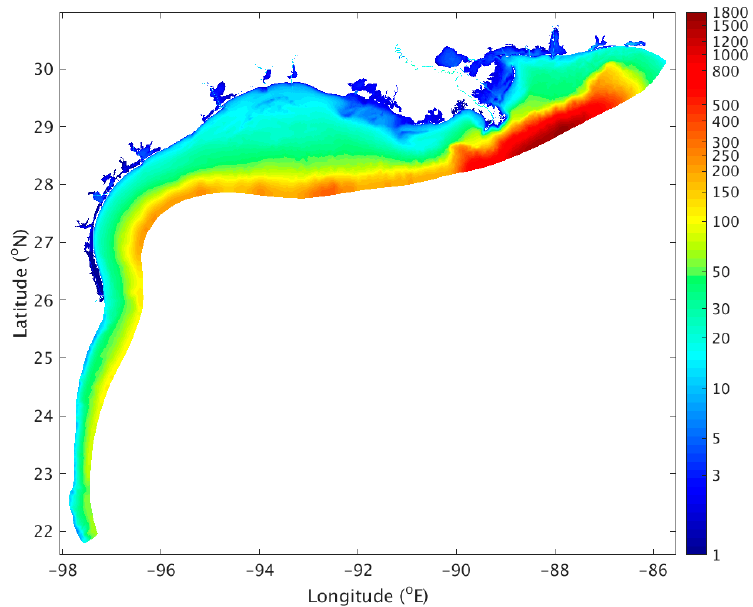
Figure 5. The INGOFS model grid bathymetry. Color bar is in